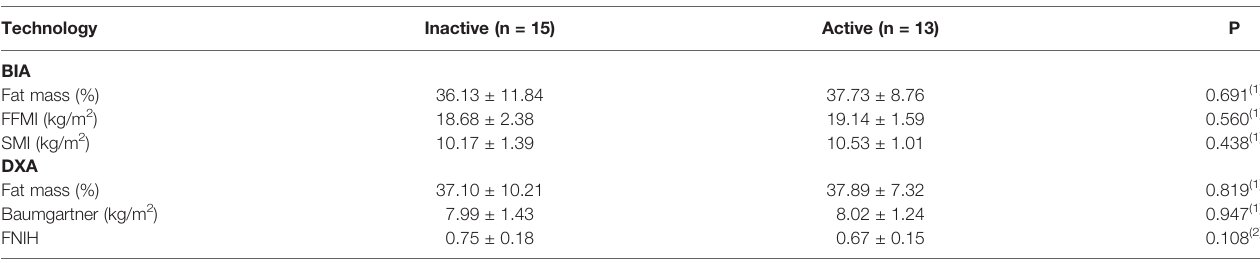
TABLE 2 | Body composition analysis according to disease activity.